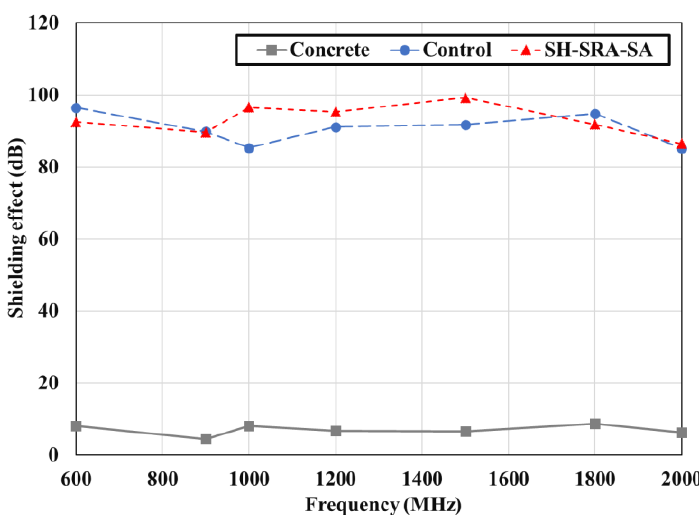
Figure 12. Results of shielding effect at 1000 MHz.